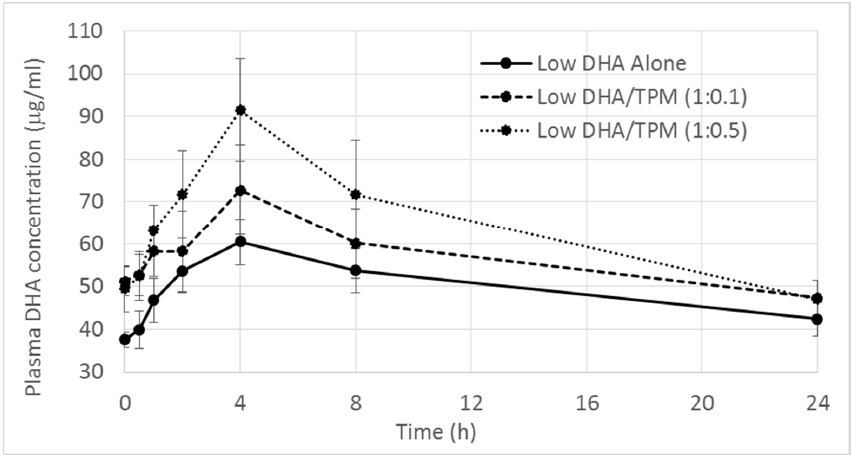
Figure 1. Mean DHA plasma concentrations versus time following single oral doses of low omega-3 formulations with increasing TPM (bars represent SEM).